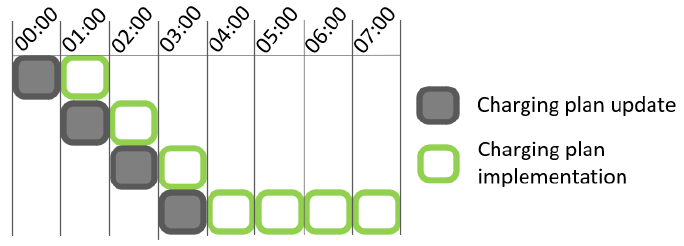
Figure 1. Illustration of an example of the algorithm’s execution.